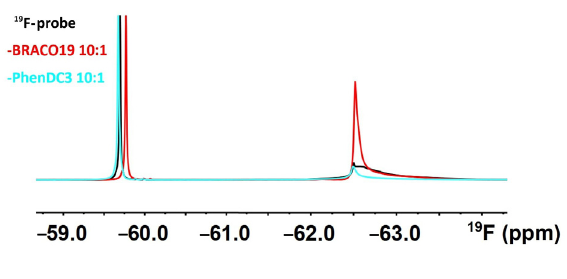
Figure 5. 1D 19 F NMR spectra of the 19 F-probe (cf. Figure 4A) in the absence (black) and the presence of BRACO19 (red) and PhenDC3 (blue).